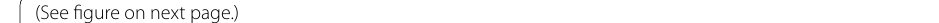
OS overall survival, TTP time to progression Variables were adopted for prognostic significance using univariate analysis ( P < 0.05). Bold P values less than 0.05, indicating statistical